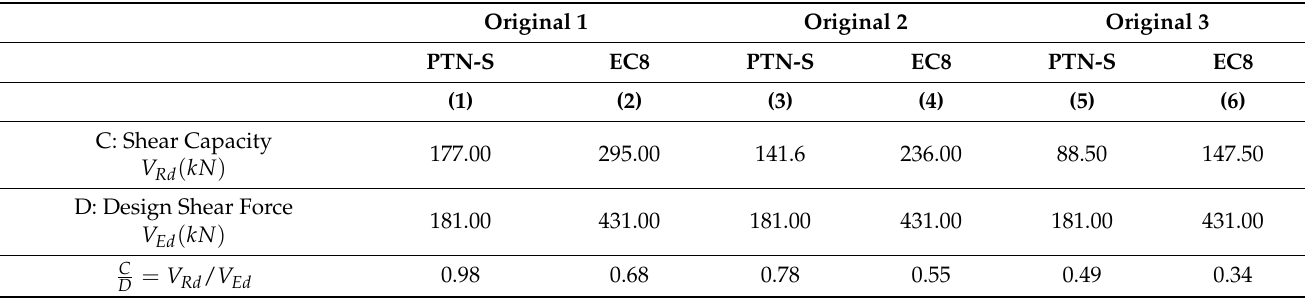
Table 8. Comparison of the seismic capacity (C) and demand (D) for the analyzed wall at the ground floor level (for the original structure).